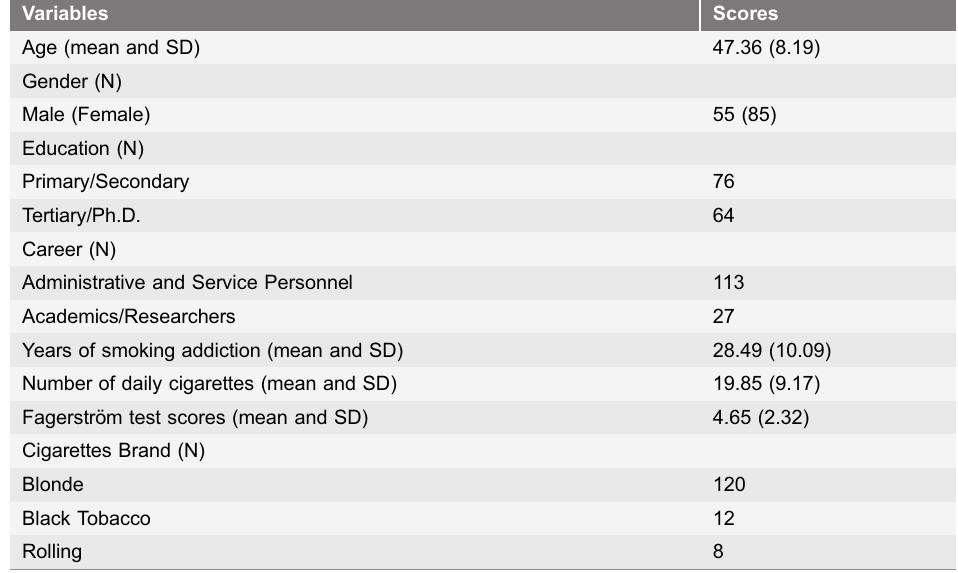
Table 1. Baseline demographic and smoking characteristics of the